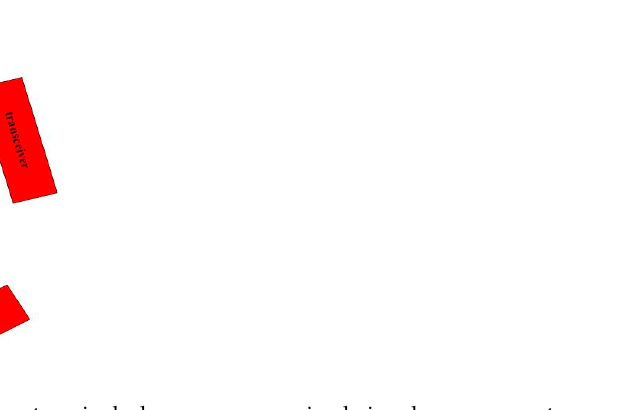
Figure 3. A body sensor node structure includes sensors, a mixed-signal processor, storage, a transceiver unit, an energy source, and an actuator unit [5,23].